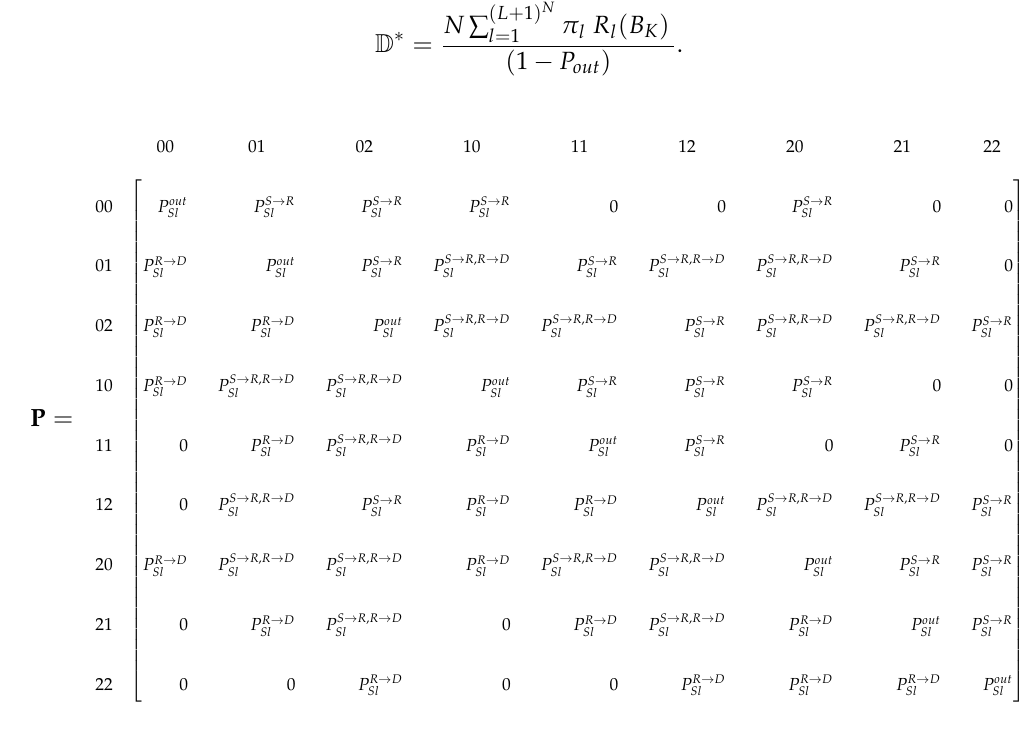
Figure 11. State transition matrix for K = 2 and L =